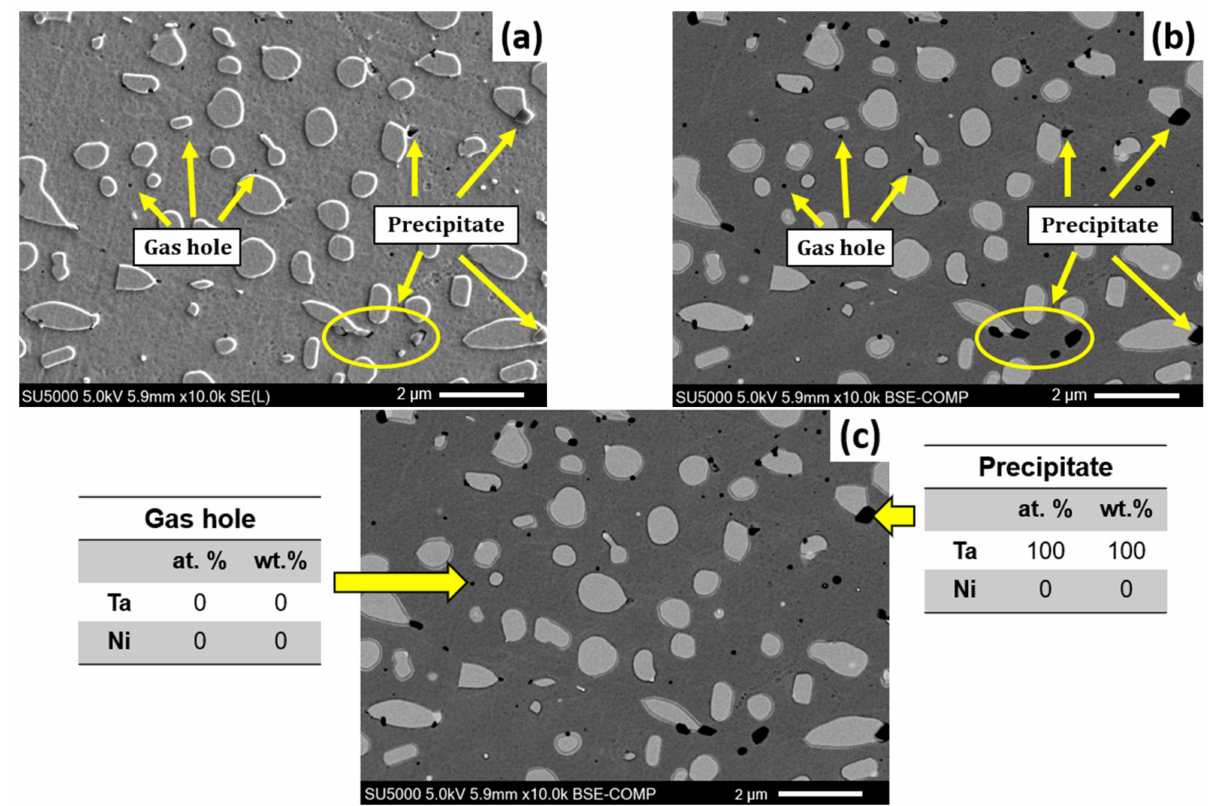
Figure 14. Formation of precipitates and gas holes in the microstructure of case 6 under ( a ) SEM-SE, ( b ) SEM-BSE and ( c ) point EDX